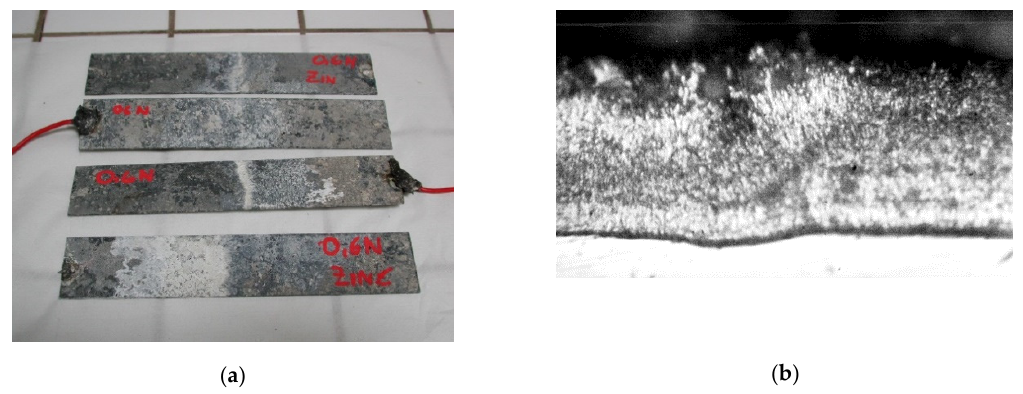
Figure 10. Visual obs. ( a ) and metallographic cross section ( b ) of galvanized steel plate in Nat-0.6